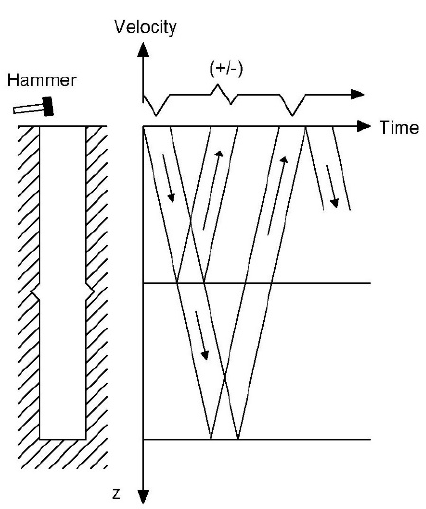
Figure 5. Pile with the bulge.